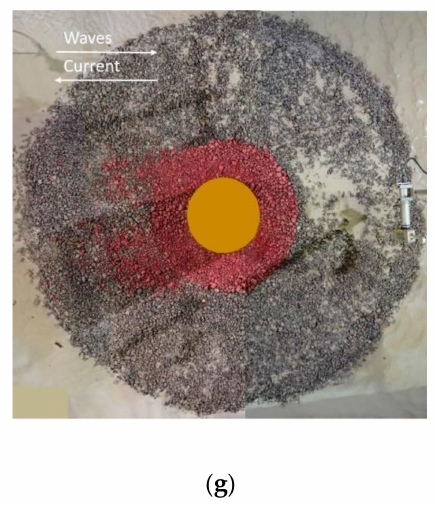
Figure 10. Overhead photos of the scour protection layer after 3000 waves: ( a ) Test 02B; ( b ) Test 04B; ( c )